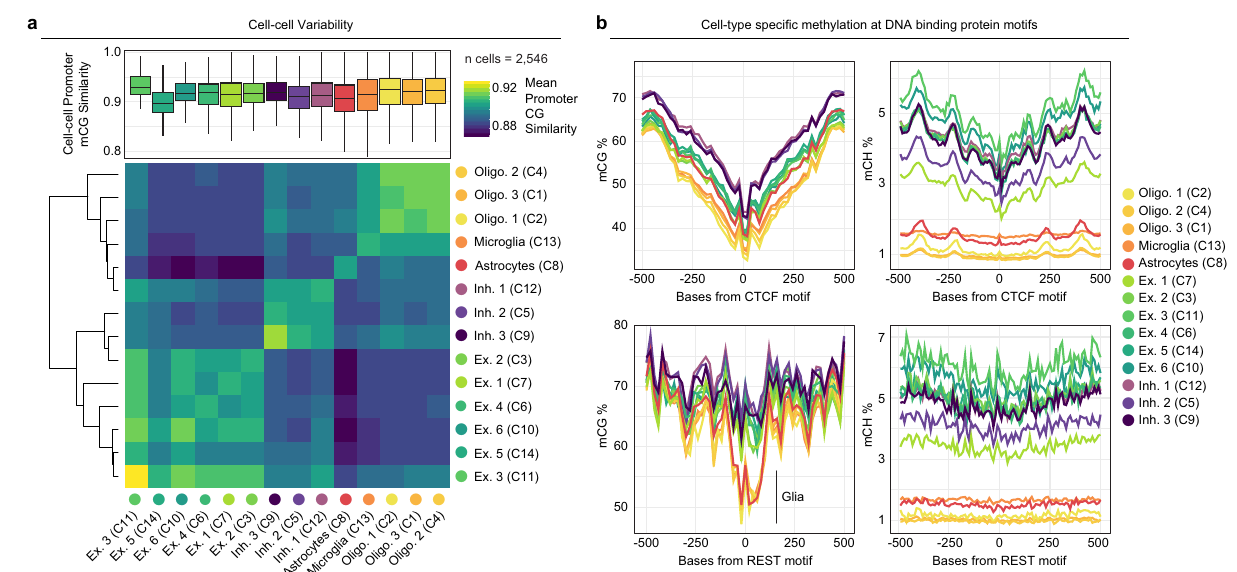
Fig. 5 | Cell-cell variability and motif analysis of sciMETv2 data. a Cell-cell variability as measured by all-by-all methylation similarity at promoter CG sites within each cluster (top), and the mean similarity for cells of different cell types represented as a heatmap (bottom). For all boxplots, boxes indicate median, 25th